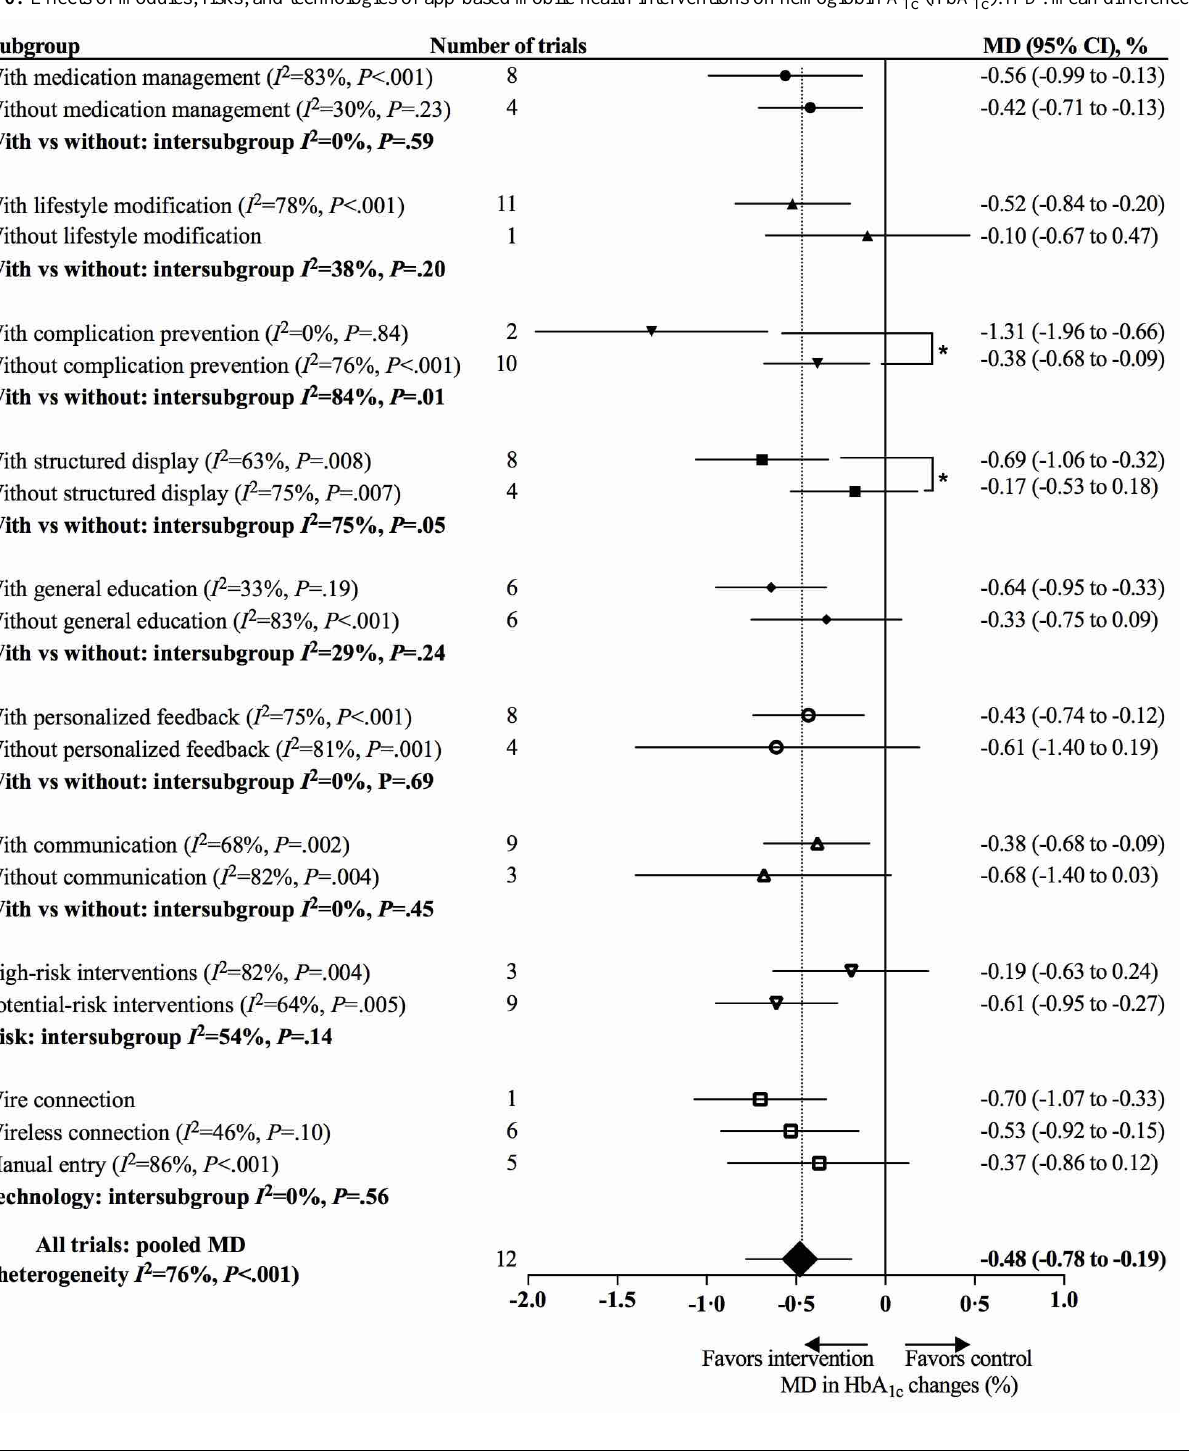
Figure 6. Effects of modules, risks, and technologies of app-based mobile health interventions on hemoglobin A 1c (HbA 1c ). MD: mean